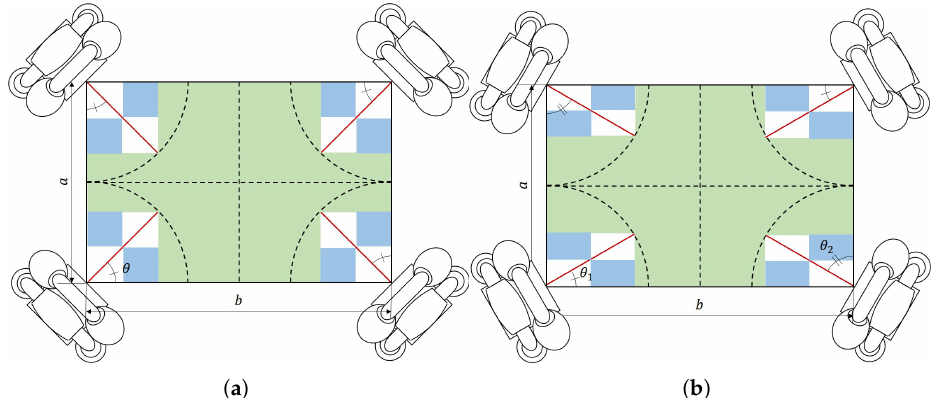
Figure 1. Pattern diagram of the area where parts can be placed: The actuators of length L are placed at an angle θ at the four corners of a robot of width a length b . The available areas where parts can be placed are (i) the rectangular portions separated by the actuator (light blue areas) and (ii) the remaining green area where actuators do not interfere. ( a ) θ = 45 [deg], L = a L = a 2